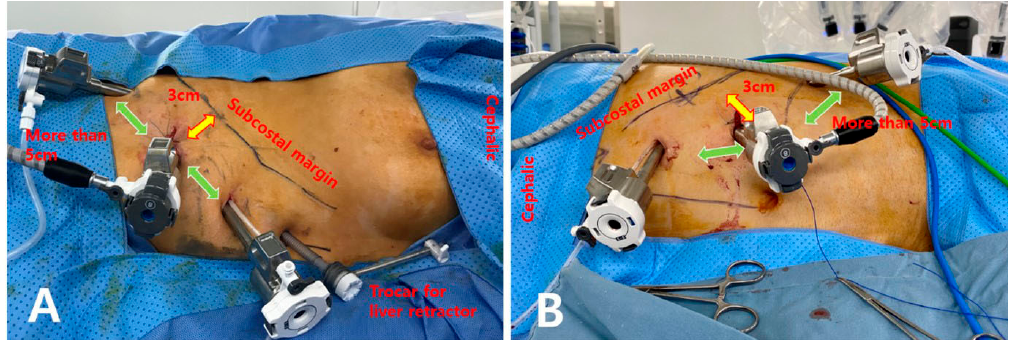
Figure 1. Trocar sites for robotic adrenalectomy. ( A ) Right adrenalectomy. ( B ) Left adrenalectomy. The steps for right RA are shown in Figure 2. The right triangular ligament was detached to sufficiently mobilize the right liver (Figure 2A). Then, a snake retractor was inserted, the mobilized right liver pulled up, and the location of the inferior vena cava (IVC) was identified (Figure 2B). After opening Gerota’s fascia, the upper pole of right kidney was identified. After dissecting upward along the superior pole of the right kidney, the right adrenal gland was identified (Figure 2C). The medial side of the adrenal gland was carefully dissected to find the adrenal vein (Figure 2D), and it was divided after hem ‐ o ‐ lock ligation (Figure 2E). The adrenal resection was terminated by completing the peripheral adrenal dissection (Figure 2F).